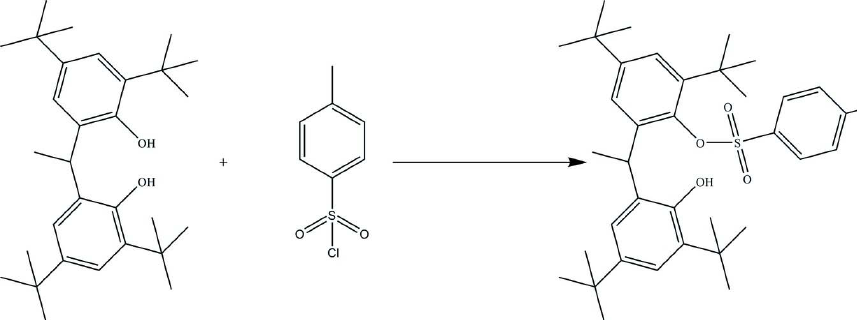
sup-2 Acta Cryst. (2009). E 65 , o155